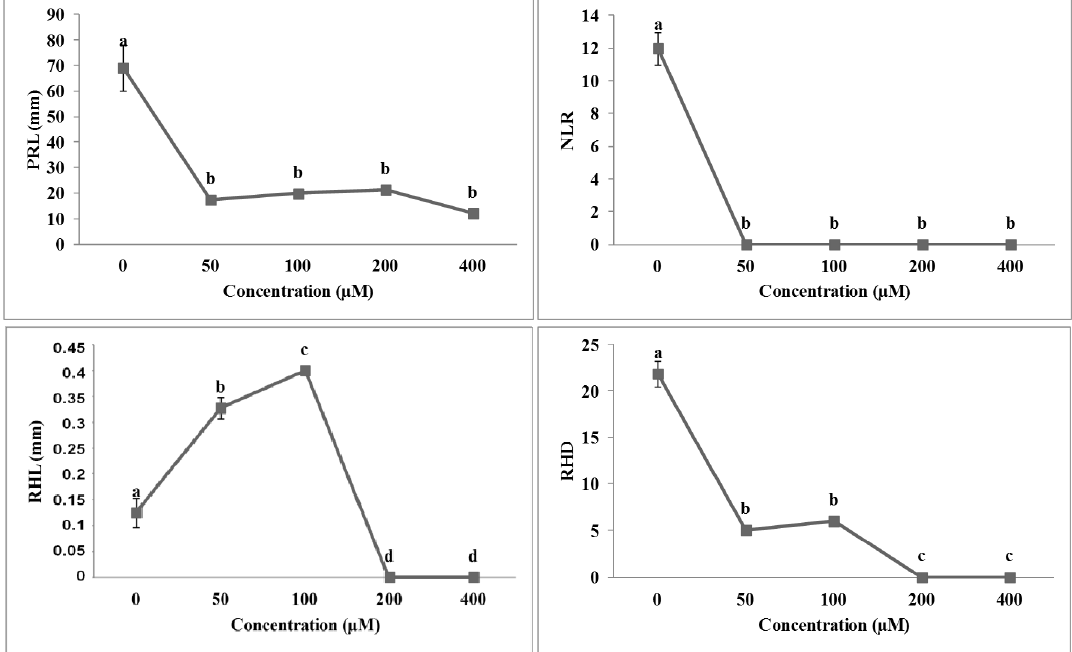
Figure 3. Dose-response curves of root morphology of A. thaliana seedlings treated with compound 1 : primary root length (PRL), number of lateral root (NLR), root hair density (RHD) and root hair length (RHL). Data are expressed as percentage of the control. Different letters along the curves indicate significant differences at p ≤ 0.05. All data were analyzed by ANOVA, applying Tukey’s and Tamhane’s T2 tests for homoscedastic and heteroscedastic parameters, respectively ( N =